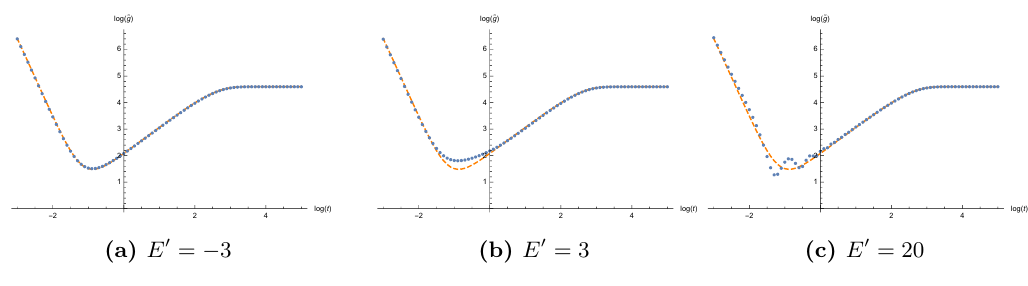
Figure 6. Plot of SFF g ( t, β, E 0 ) with β = 1 / 100 for a E 0 = − 3 , b E 0 = 3 and c E 0 = 20 as a e function of t . The blue dots represent the SFF in the presence of two FZZT branes at ξ = − E 0 , while the orange dashed curve represents the SFF without the FZZT